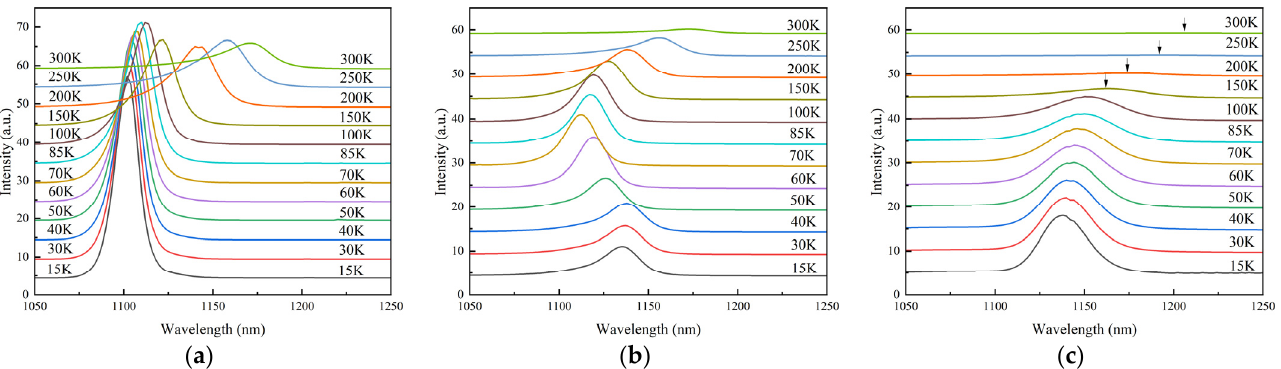
Figure 6. Temperature-dependent of PL spectra for InGaAs/GaAsP QWs on ( a ) 0 ◦ , ( b ) 2 ◦ , and ( c ) 15 ◦ misoriented